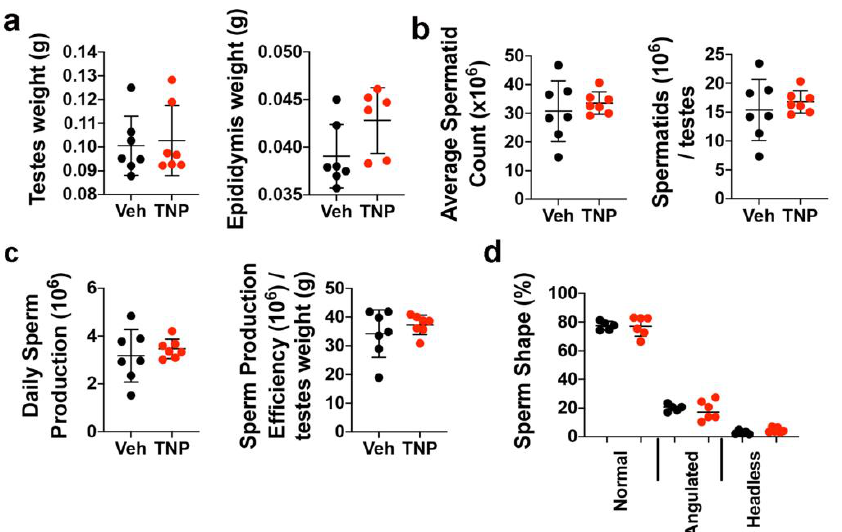
Figure 4. Prolonged TNP administration does not impair spermatogenesis in male mice. ( a ) Weight of testes and epididymis from vehicle- or TNP-treated HFD mice. ( b ) Average spermatid counts and spermatid concentrations per testes. ( c ) Daily sperm production and sperm production efficiency. ( d ) Percentages of sperm with normal morphology or abnormalities, including angulated midpieces and headless tails. Data are mean ± SD (n = 6–7 mice/group). In Prism 9, p -values are by Student’s t test.